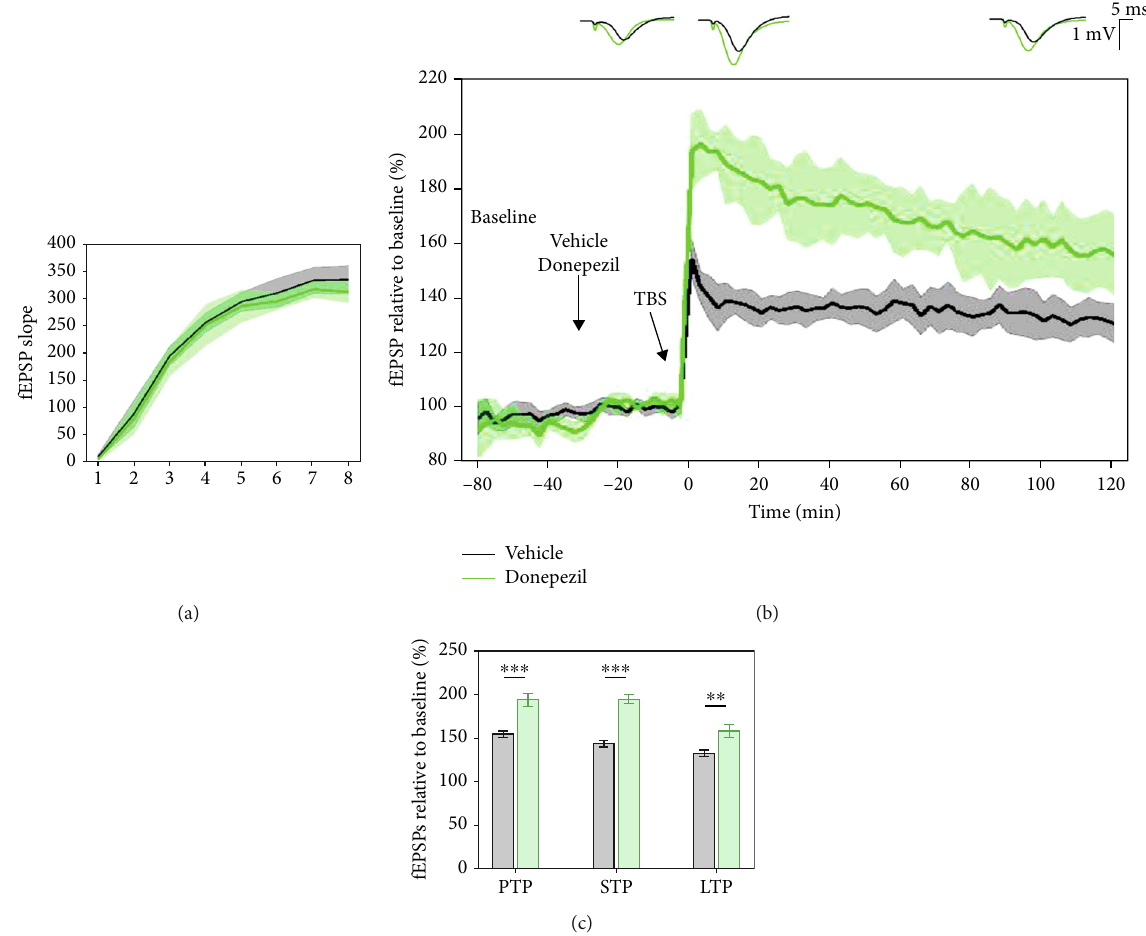
Figure 9: Donepezil (1 mg/kg) signi fi cantly enhanced 5 × TBS LTP response when compared to control, saline-treated subjects. (a) Collective input/output curves of stimulation voltage and fEPSP slope overlap and show no signi fi cant di ff erence in basal synaptic excitability prior to treatment with donepezil. However, the average response between 9 and 10V showed a slightly lower response than control subjects in donepezil-treated subjects. (b) Basal fEPSPs were not a ff ected; however, the LTP response of donepezil-treated subjects (green, n = 5 ) was signi fi cantly greater than control, saline-treated subjects (black, n = 10 ). Values represent mean ± 95 % confidence intervals . Outsets above LTP curves represent average waveform fi eld potentials during 30min baseline prior to tetanisation and 0-30 min and 90-120 min posttetanisation. Horizontal bar: 1 mV; vertical bar: 5 ms. (c) PTP, STP, and LTP responses are presented as means ± 95 % confidence intervals ; ∗∗ p value < 0 : 01 and ∗∗∗ p value < 0 : 001